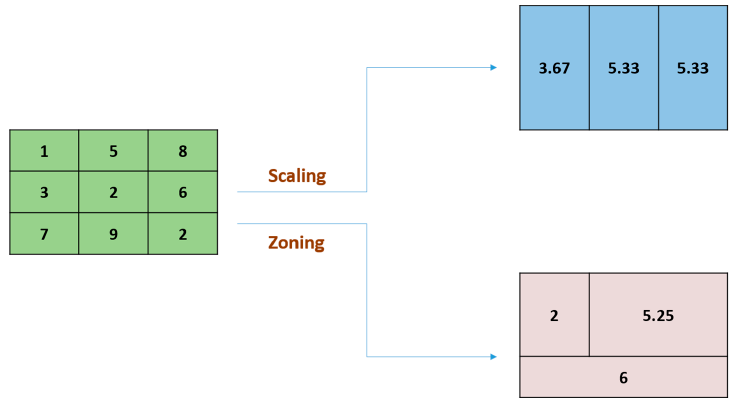
Figure 1. An illustration of the Modifiable Areal Unit Problem (MAUP). On the left side an original high-resolution dataset is shown, while the right side illustrates two different results of spatial aggregation of the original data from scaling (scaled to coarser scale/resolution with same spatial size) and from zoning (scaled to the coarser scale/resolution by areas with different spatial sizes). The spatial pattern of the averaged values depends on the boundaries of the spatial units of aggregation.